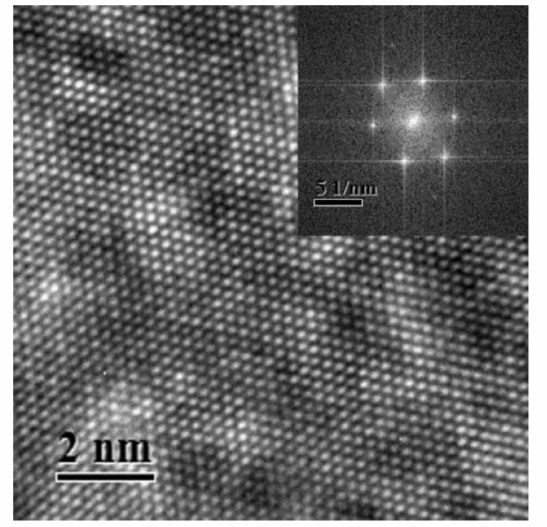
Figure 1. High resolution transmission electron microscopy (HRTEM) image of the nanostructure of Al-0.2 wt.%Ag sample aged at room temperature after quenching. The inset view is the Fast Fourier Transform (FFT) of the HRTEM